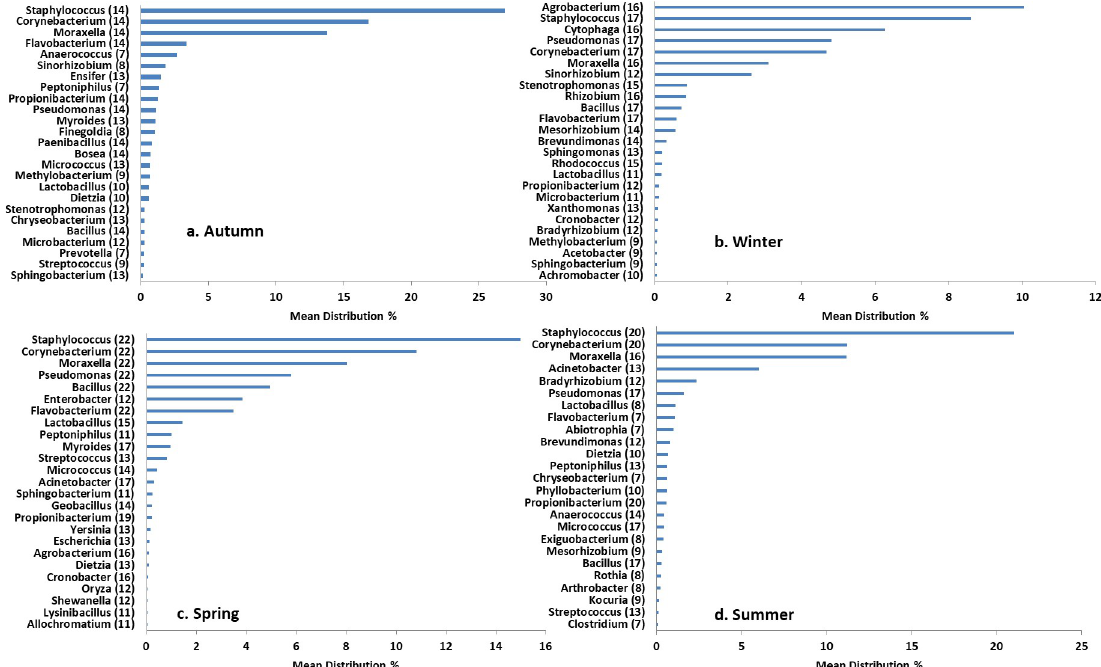
Fig 5. Bacterial genera of the nasal cavity of health care professionals of a clinical research laboratory in (a) Autumn; (b) Winter (c) Spring and (d) Summer. The graphs depicting the mean distribution (MD) of bacterial species were plotted in ggplot. The longer the bar, the higher the abundance. Names of the genera are plotted on the left-hand side. The values in the bracket indicate the number of samples analyzed in a particular